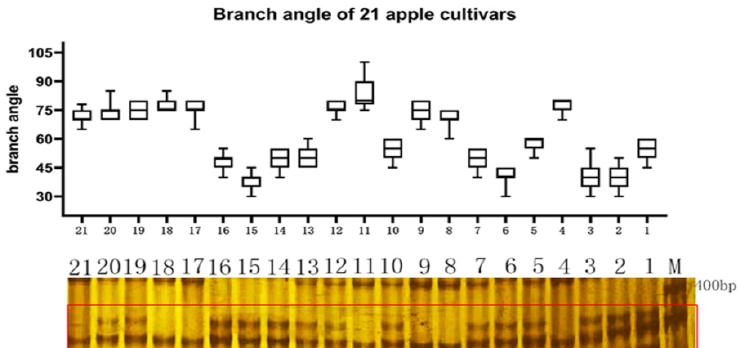
Figure 7. Genotyping of TAC1a in apple cultivars by an InDel markerThe upper imageshowedthe branch angle size of 21 apple cultivars, and the lower electrophoresis pattern showed the separation of TAC1a marker in the 21 cultivars, 1-21 represented sequentially ‘Zhongqiuwang’, ‘Red star’, ‘Envy’, ‘Brilliant’, ‘Red jade’, ‘Huashuo’, ‘Venus golden’, ‘Huangyuxiang’, ‘Qincui’, ‘Tuoji’, ‘Dew’, ‘Xiwang’, ‘Jinzhouhong’, ‘Daphne red’, ‘Jinxianghong’, ‘Huirui’, ‘Max’, ‘Huajia’, ‘Yanfu NO.6’, ‘Yanfu NO.10’, ‘Yanfu NO.8’.